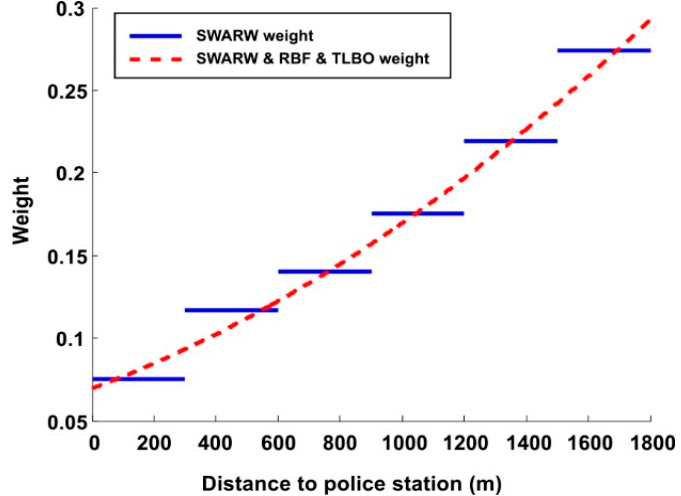
Figure 5. Example of the calculated weight using SWARA and its optimization using RBF and TLBO.